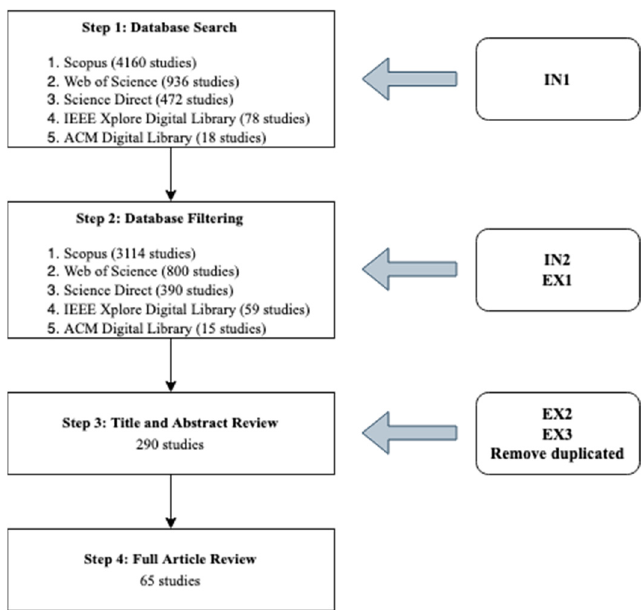
Figure 1. Flow chart with the results of the study selection process.